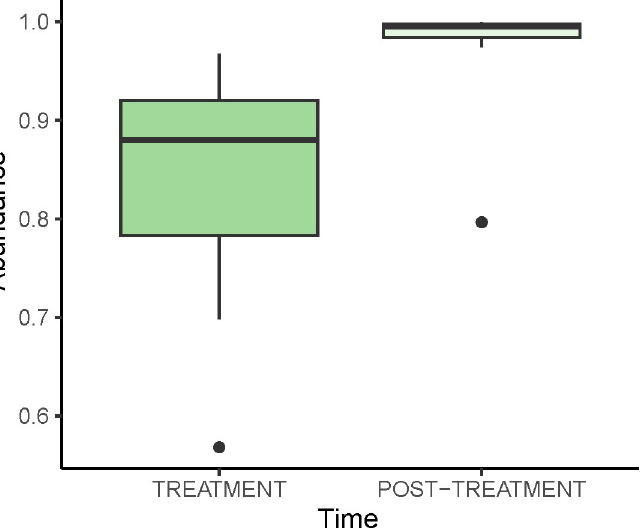
Fig 1. Box and whisker plot of Domain Bacteria (%) in fawn-footed mosaic-tailed rat ( Melomys cervinipes ) faecal samples. For rats treated with antibiotics (TREATMENT) and more than one year later (POST-TREATMENT).